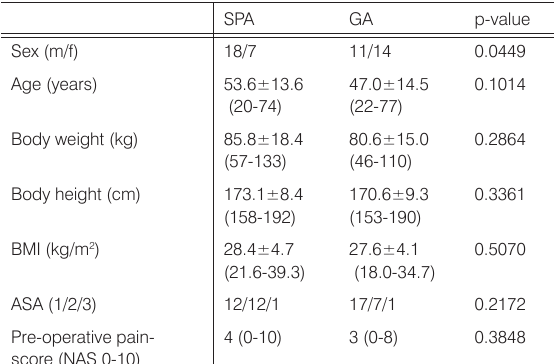
Table 2. Demographic data of patients. Quantitative parameters are given by mean, standard deviation and range, qualita- tive by frequencies. Pain score ist described by the median values. SPA, spinal anaesthesia, GA, general anaesthesia, BMI, body mass